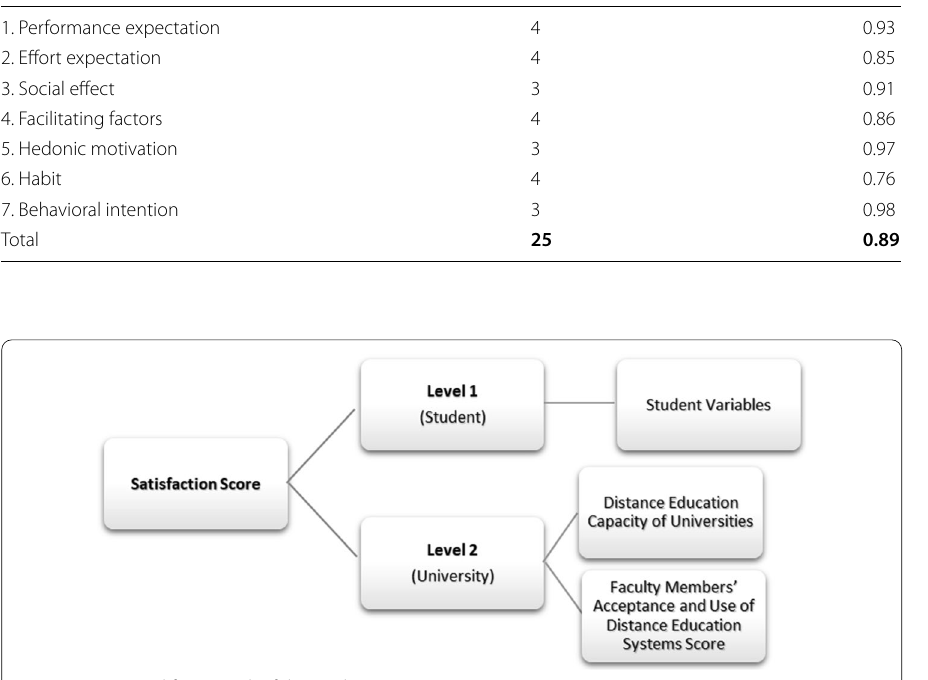
Table 2 Cronbach’s Alpha reliability coefficients of the scales Acceptance and use of distance education systems scale